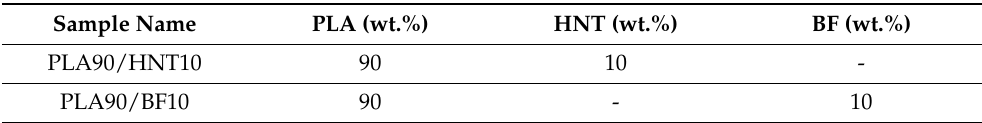
Table 1. Blend compositions prepared for this